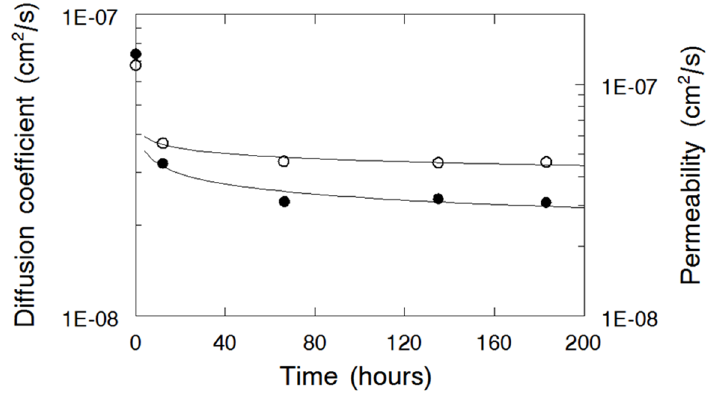
Figure 8. Diffusion coefficient ( ● ); and steady ‐ state permeability ( ○ ) of Br 2 /Br 3 ‐ in N(fibers)/PPSU nanofiber composite membrane as a function of soak time in a solution of 0.14M Br 2 in 2M HBr at 25 °C.